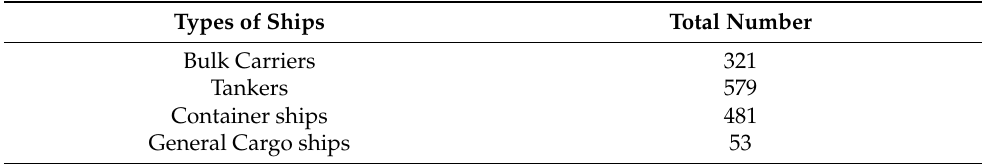
Table 2. Number of ships by types arriving at MBQP in 2020.